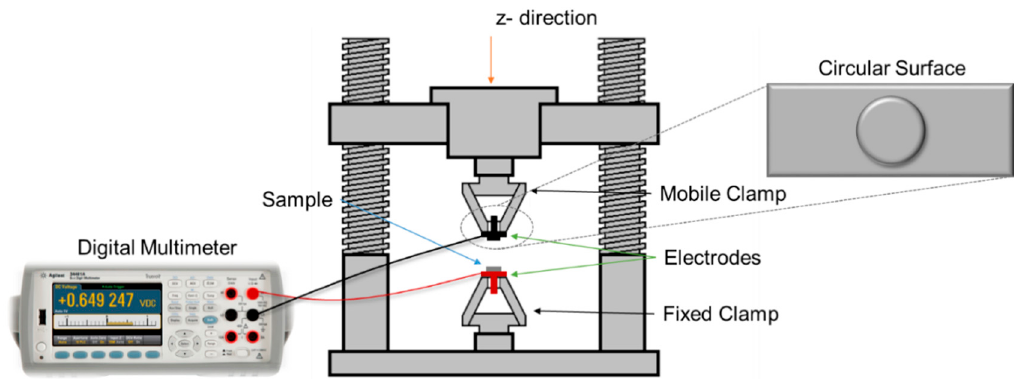
Figure 2. Schematic representation of the experimental configuration for the piezoresistive performance evaluation.